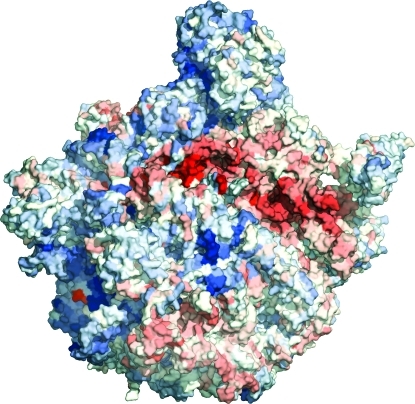
PCA Plot of the 70S Ribosomal Subunit from Haloarcula marismortui
The second principal component is plotted for a superposition of 10 subunits of the large ribosomal subunit bound to different antibiotics. The subunit interface (which binds the small ribosomal subunit) is facing the viewer, with the 5S RNA at the top of the image. The large horizontal swath of “red” correlation co-localizes with the active site cleft that binds the mRNA, tRNAs, and translation factors. The first principal component (not shown) indicates a relatively simple, large-scale hinge-like motion in which the top third of the 70S subunit (in the orientation shown) is positively correlated with the bottom third.